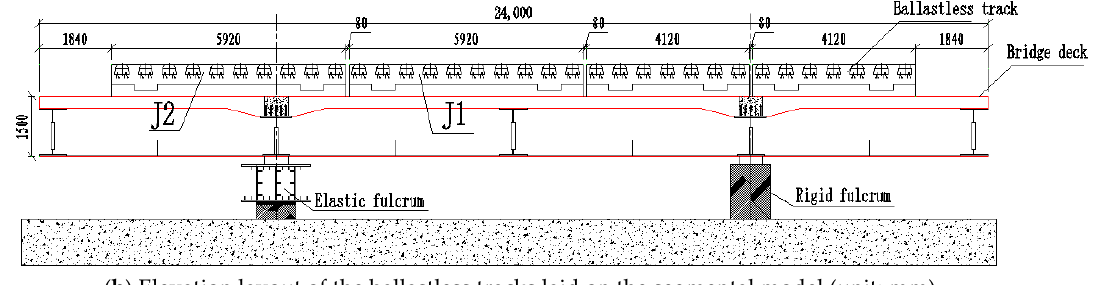
Figure 6. The ( a ) plane and ( b ) elevation layouts of the ballastless tracks laid on the segmental model.